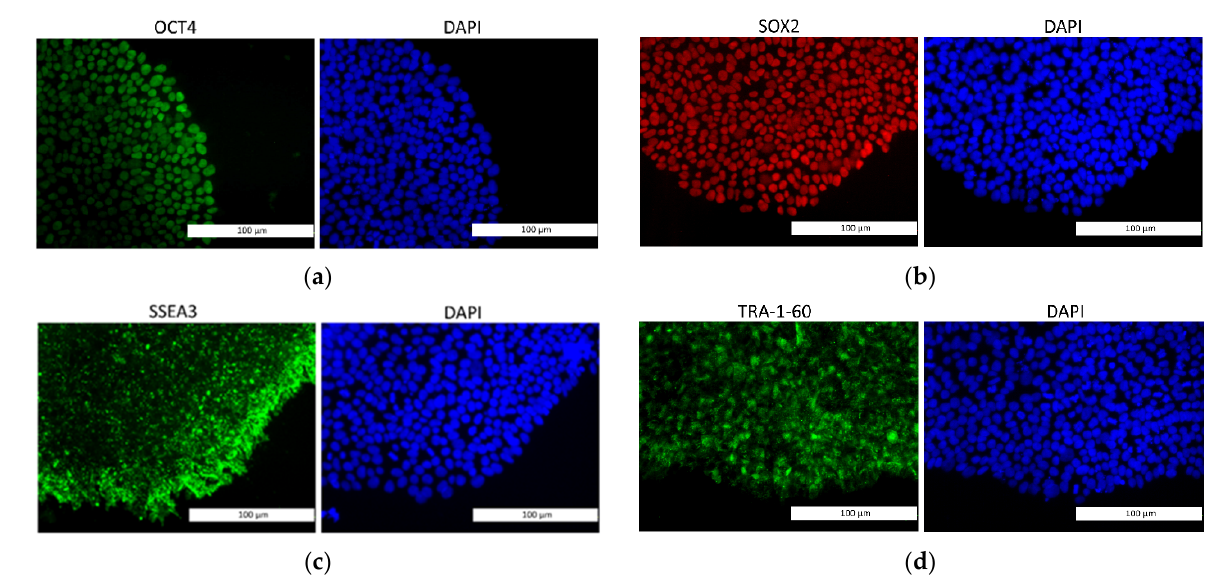
Figure 1. Immunohistochemical staining for evaluation of the expression of pluripotency markers: ( a ) OCT4; ( b ) SOX2; ( c ) SSEA3; ( d ) TRA-1-60. Expression of OCT4, SOX2, SSEA3, TRA-1-60 was found in both karyotypes. Fluorescence microscopy, the scale length in all pictures is 100 µm.